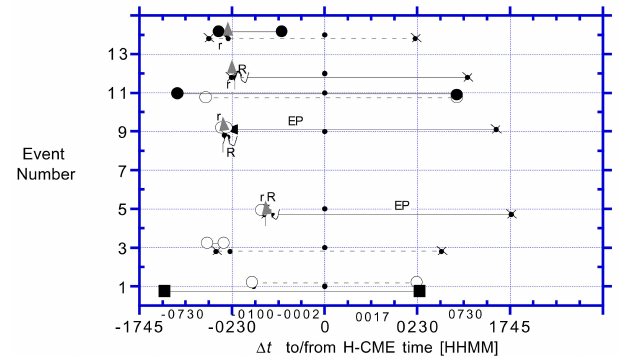
Fig. 4. Seven time lines of chromospheric and corona disturbances measured with respect to the observation time of the halo-CME (Ta- ble 2). The vertical axis indicates the event each time line belongs to. A solid line connects start and end times of a well identified so- lar disturbance, while a dash-line indicates a tentative identification. Open circle (o) stands for chromospheric filament disappearance; Solid circle ( • ) for filament eruption in UVI light; Crossed-dot ( ×• ) for soft X-ray LDE; Hatched-triangle ( 4 ) for optical flare; Solid- square ( (cid:4) ) for new arcade formation; Curly-symbol for the onset of EIT-wave; letter “ r ” for metric radio bursts; letter “ R ” for the start of decametric radio bursts; Letters “EP” for the inferred start time of a gradual energetic particle